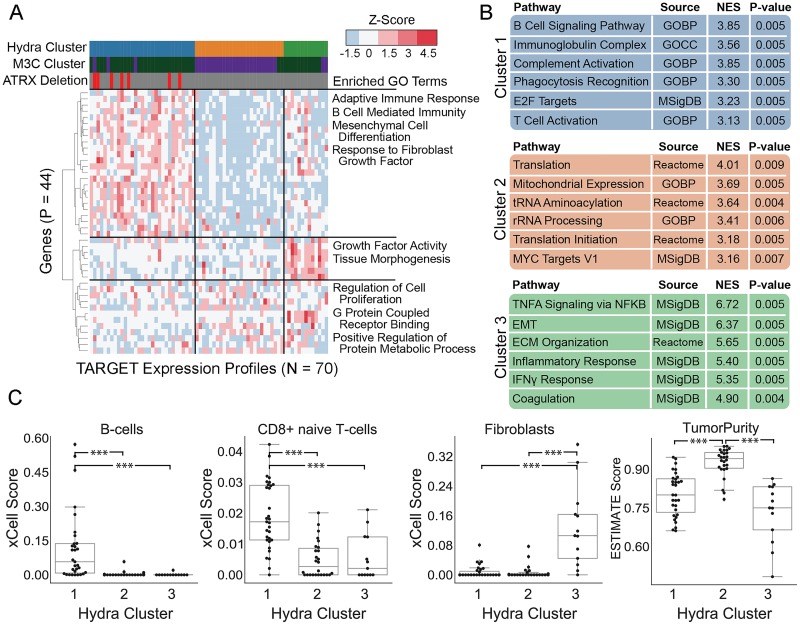
Hydra analysis identifies three distinct tumor microenvironment expression subtypes in MYCN non-amplified neuroblastoma samples.A: Gene expression heatmap displaying expression profiles of hydra clusters. Heatmap columns (samples) are ordered by hydra cluster membership. Ward hierarchical clustering applied to rows (genes) identified coordinated expression of GO term genes. These GO term genes were originally identified by the hydra enrich command. B: GSEA performed on each cluster identified enrichment of tumor microenvironment and proliferative signaling gene sets. C: xCell enrichment score distributions for B-cells, CD8+ naive T-cells, and Fibroblasts, and the ESTIMATE TumorPurity score distributions for each cluster; enrichments for all cell types are available in S1 File. Abbreviations: Normalized Enrichment Score (NES), Epithelial to Mesenchymal Transition (EMT), Extracellular Matrix (ECM), Gene Ontology Biological Process (GOBP).